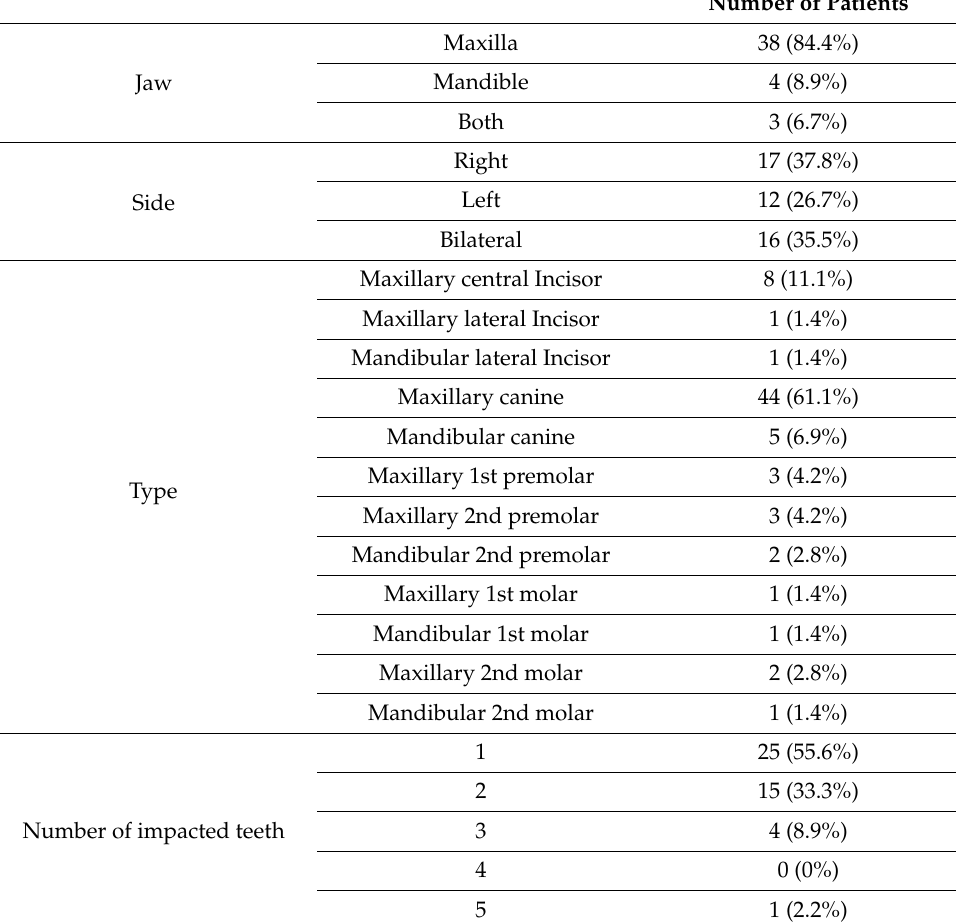
Table 3. The distribution of the impacted teeth in the study